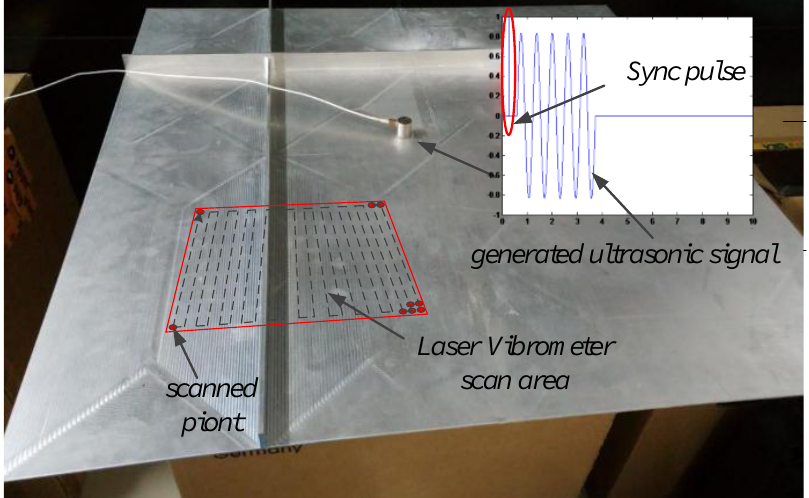
Figure 7. The schematic diagram.